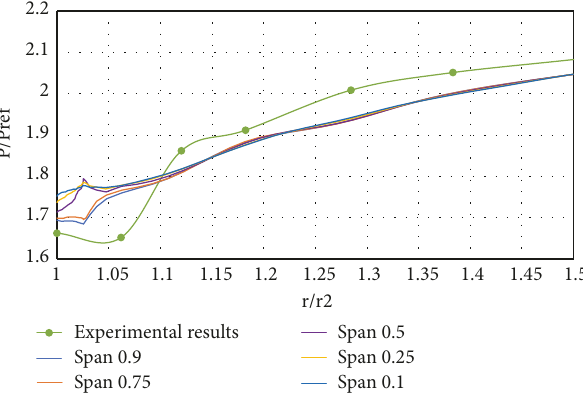
Figure 10: Pressure distribution at different spanwise positions at 461 Hz for a mass flow rate of 1.8